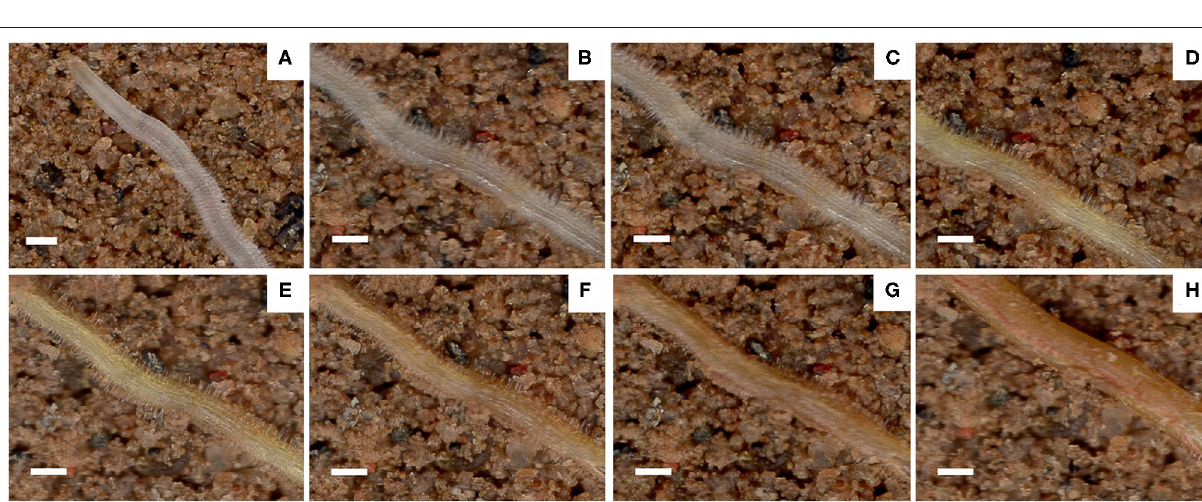
FIGURE 8 | Images of the same root area taken at different times during the life span of cotton root hairs. Scale bar, 0.5mm. Images shown are taken on (A) 30 November, (B) 1 December, (C) 6 December, (D) 12 December, (E) 18 December, (F) 24 December, (G) 30 December, and (H) 5